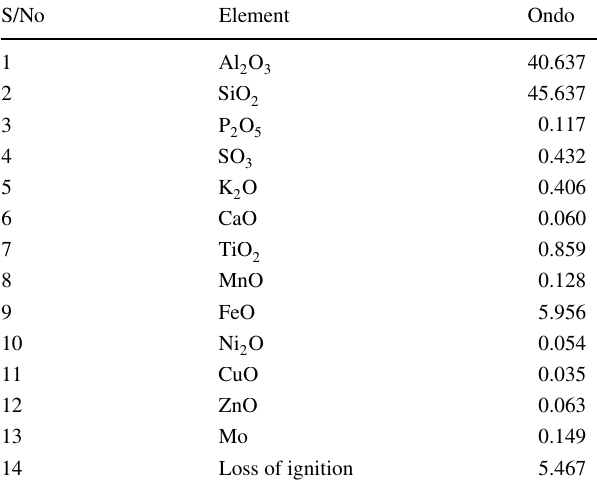
Table 1 Elemental characteristics of clay sample from Ondo State (Olubayode et al. 2016) S/No